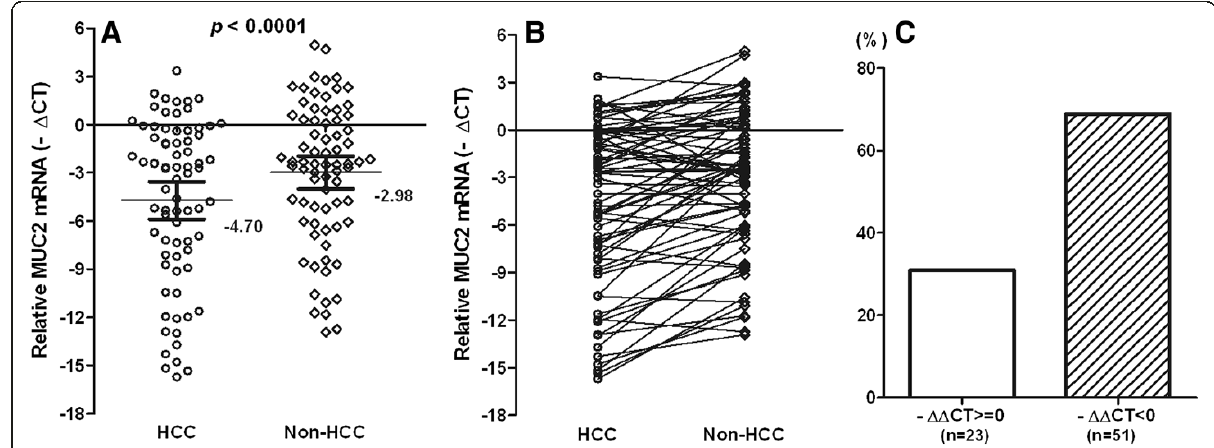
Figure 1 MUC2 mRNA in HCC and the matched non-tumor liver tissues. ( A ) The MUC2 mRNA was indicated in HCC and Non-HCC samples. Data are shown by the Mean - Δ CT and 95%CI. The MUC2 mRNA in HCC was lower than that in the matched non-tumor liver tissues ( p < 0.0001). ( B ) There was a decreased tendency for MUC2 expression from Non-HCC tissues to HCC. ( C ) Expression of MUC2 was elevated ( − ΔΔ Ct > =0) in only 23 of the 74 HCC patients but decreased ( − ΔΔ Ct < 0) in 51 of the patients. Statistical analyses were done using the paired t